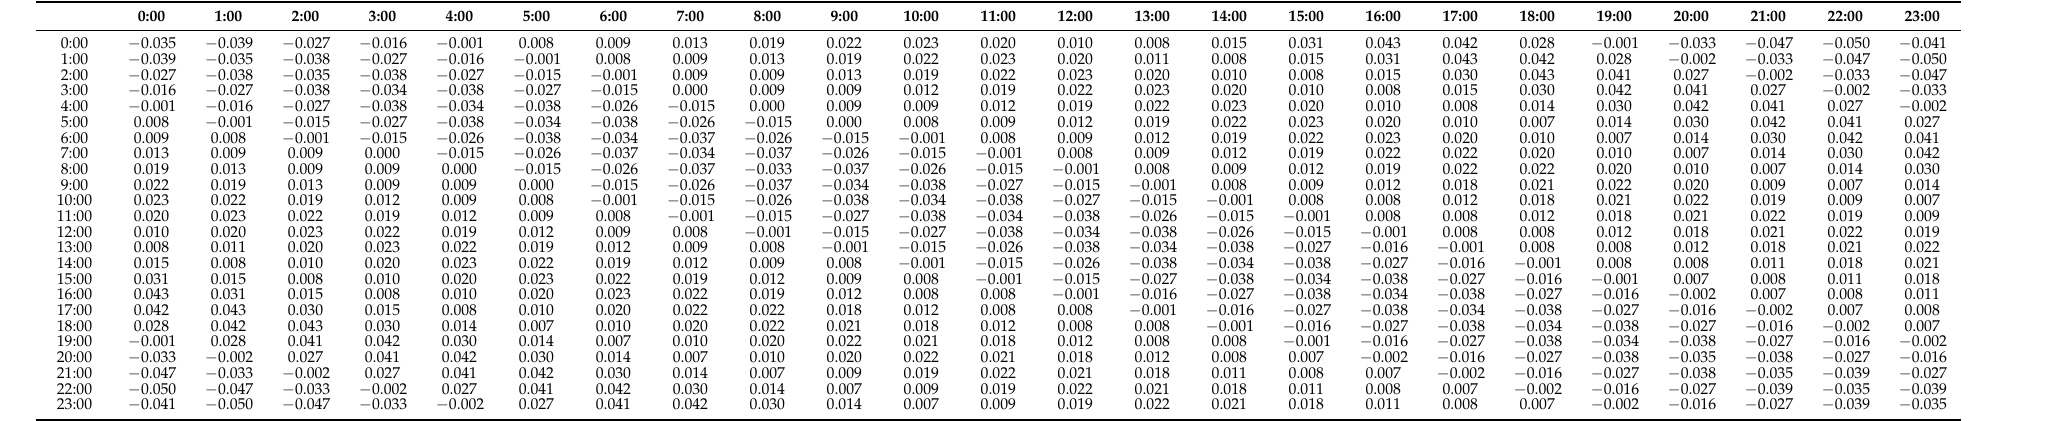
Table A2. Price elasticity coefficient of electricity demand in